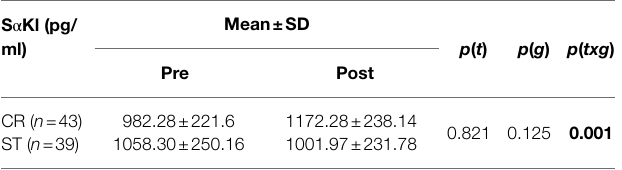
TABLE 2 | Behavior of S α Kl levels over time in the study groups. S α Kl (pg/ ml)